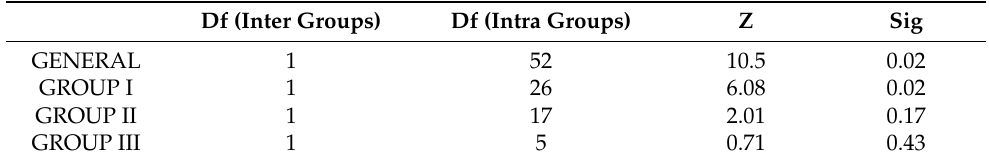
Table 2. Level of physical activity X comorbidities.